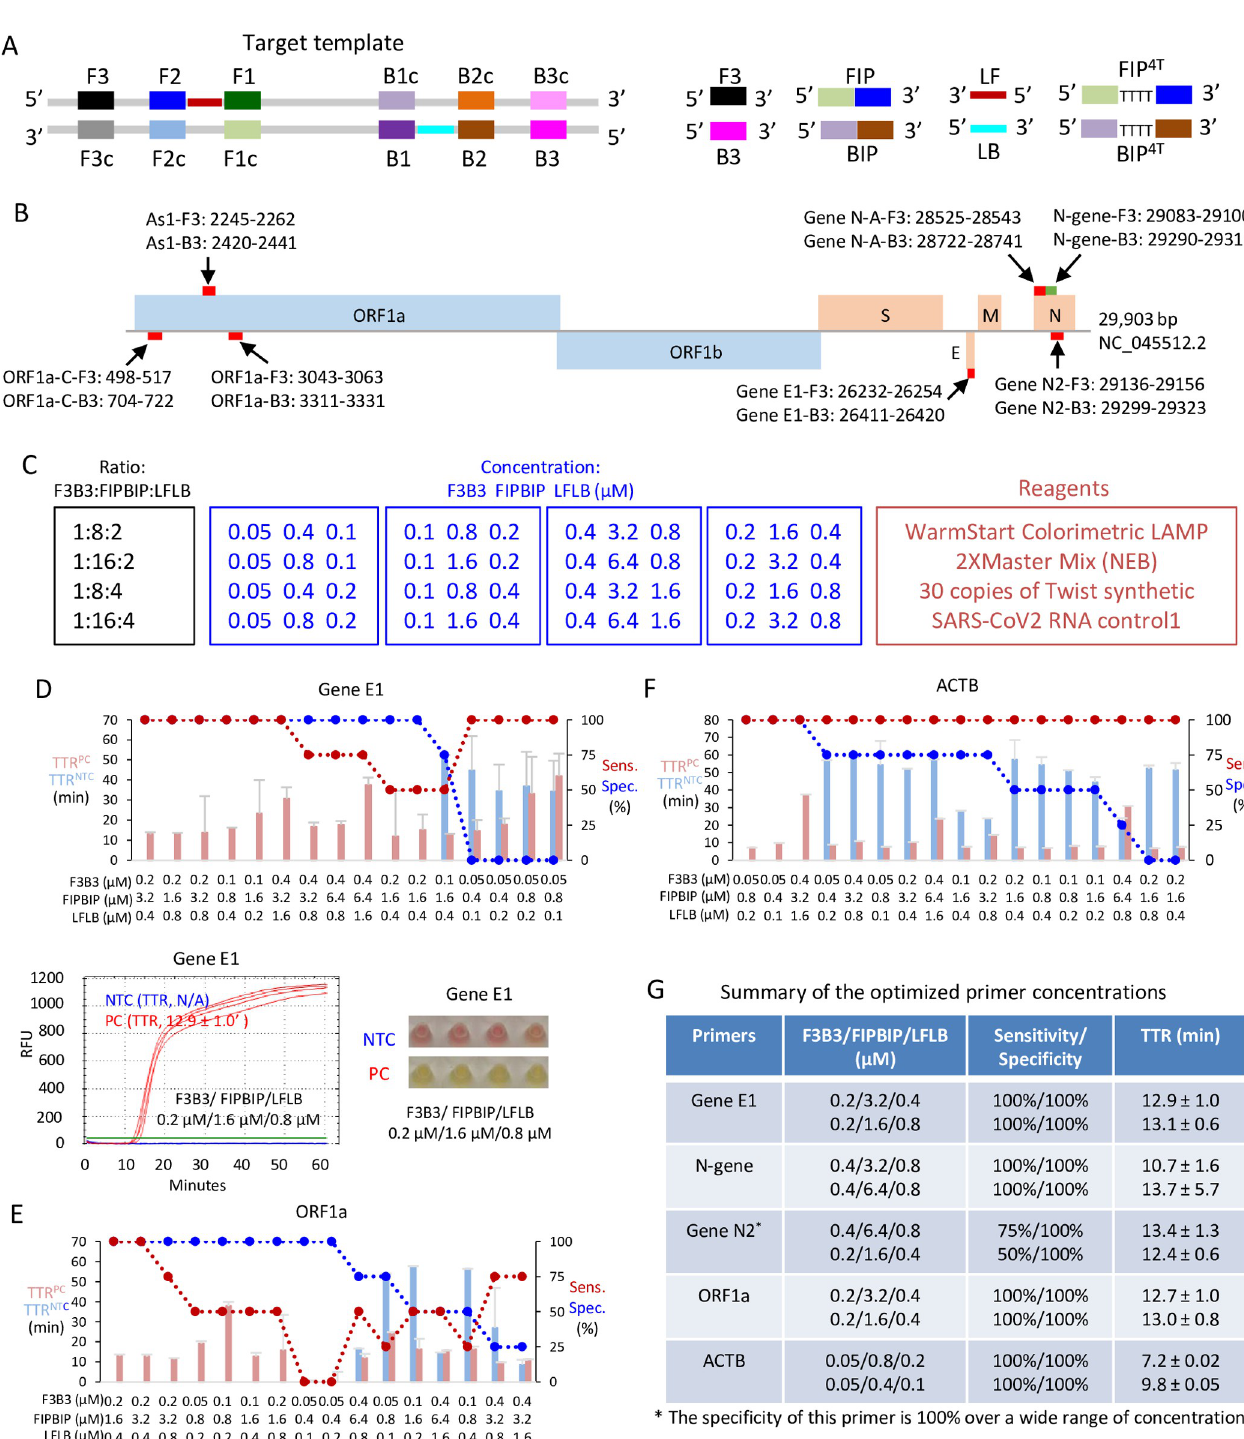
PLOS ONE | https://doi.org/10.1371/journal.pone.0268340 May 11,